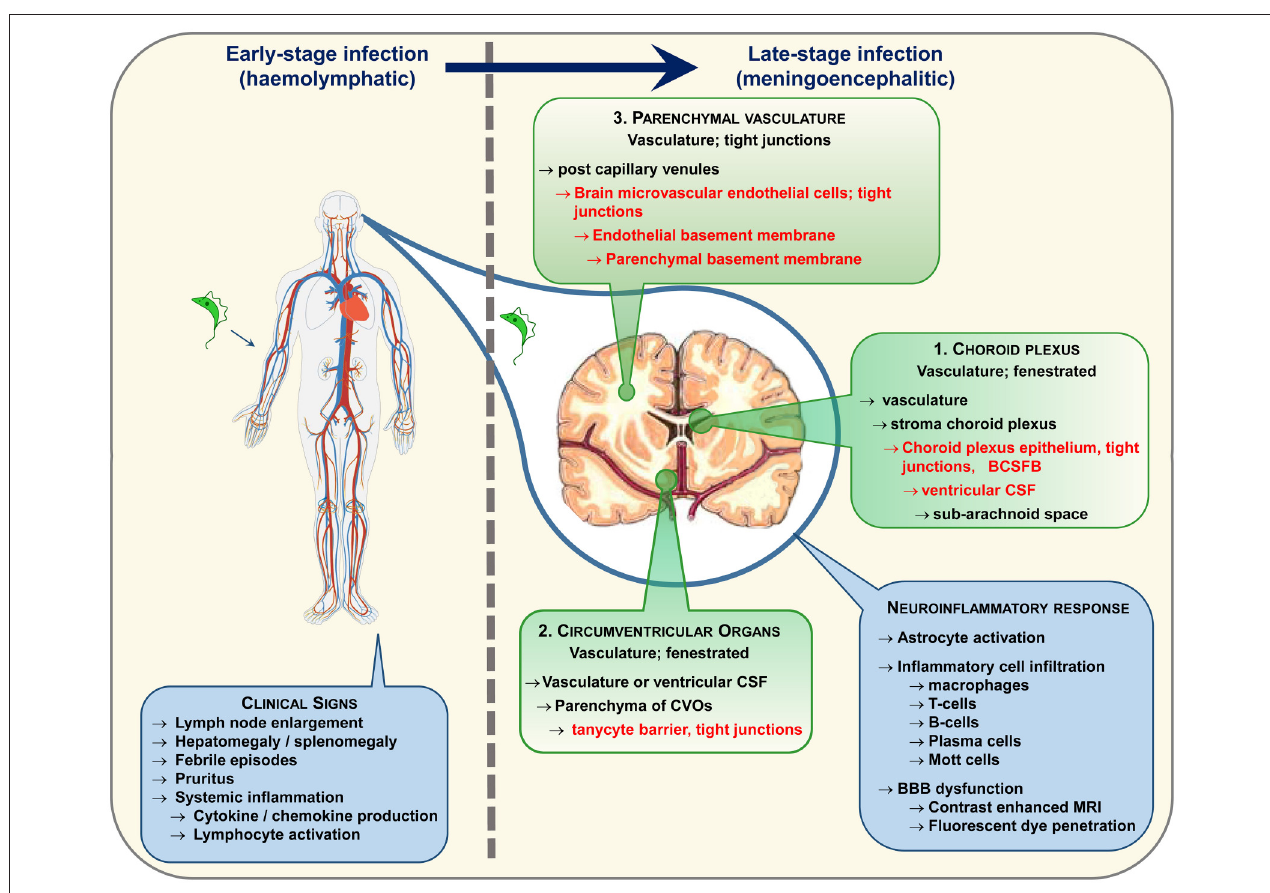
FIGURE 1 | Following infection trypanosomes spread via the haemolymphatic system to invade the peripheral organs. The infection precipitates an array of non-specific symptoms mostly linked to the systemic immune reaction. When the disease progresses from the early to the late-stage the trypanosomes enter and establish within the CNS. The routes exploited by the parasites to invade the CNS remain a topic of debate. The three main possibilities are highlighted. In each case the parasites must circumvent a potential barrier (listed in red text) to gain entry to the neuropil. It is likely that a combination of these pathways is utilized. Progression to late-stage induces a series of neuroinflammatory changes in the brain characterized by a pronounced astrocyte activation and lymphocyte infiltration. As the disease advances, progressive deterioration in blood-brain barrier (BBB) function has been noted following systemic injection of fluorescent dyes and contrast enhanced magnetic resonance